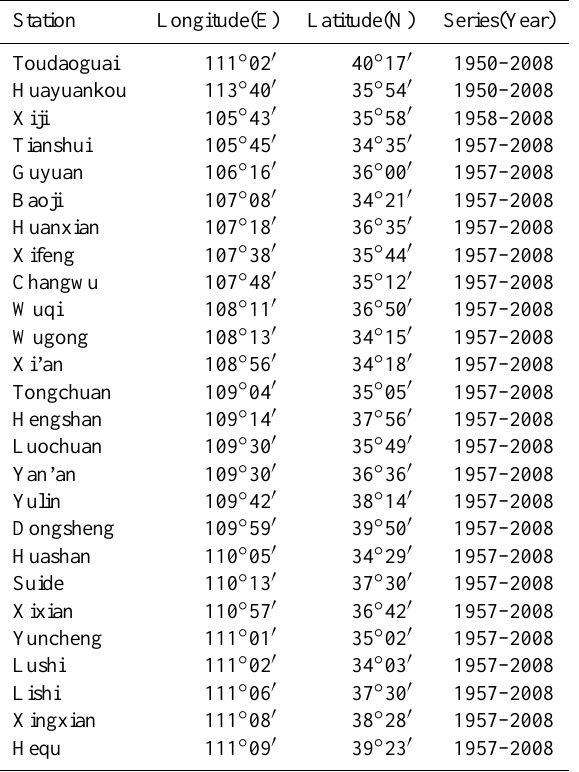
Table 1. The location and data series of the hydrologic and rain